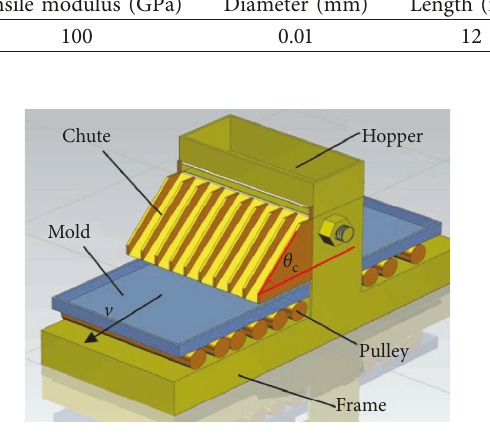
Figure 1: The chute stretch device.